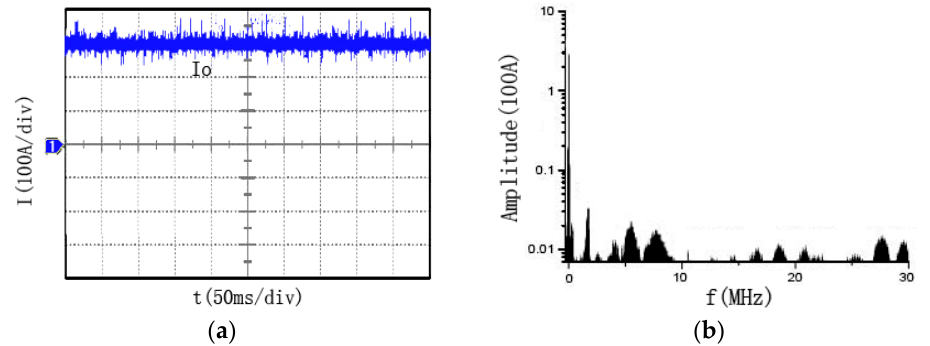
Figure 16. The experiment current waves of the DC power generation: ( a ) Output current wave; ( b ) output current spectrum.